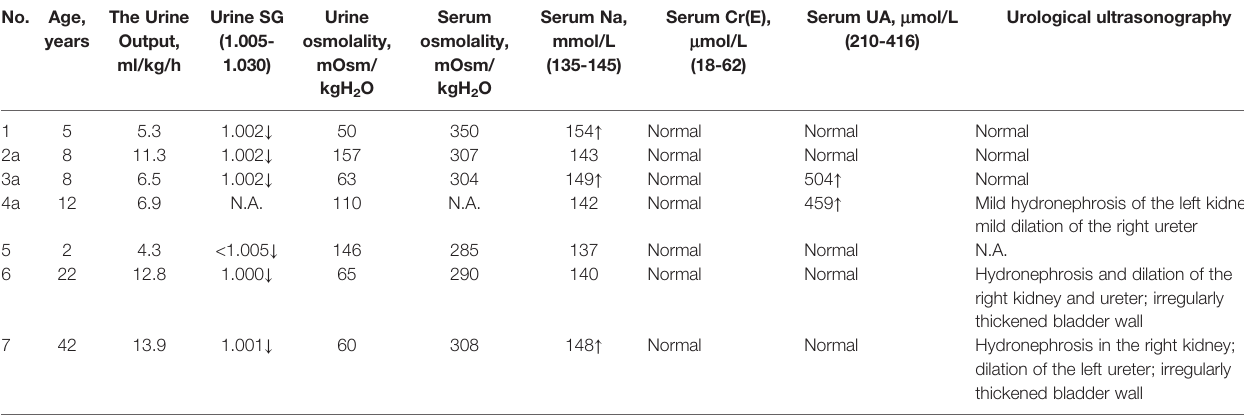
TABLE 3 | Biochemical and radiological characteristics in patients with NDI. No. Age, The Urine years